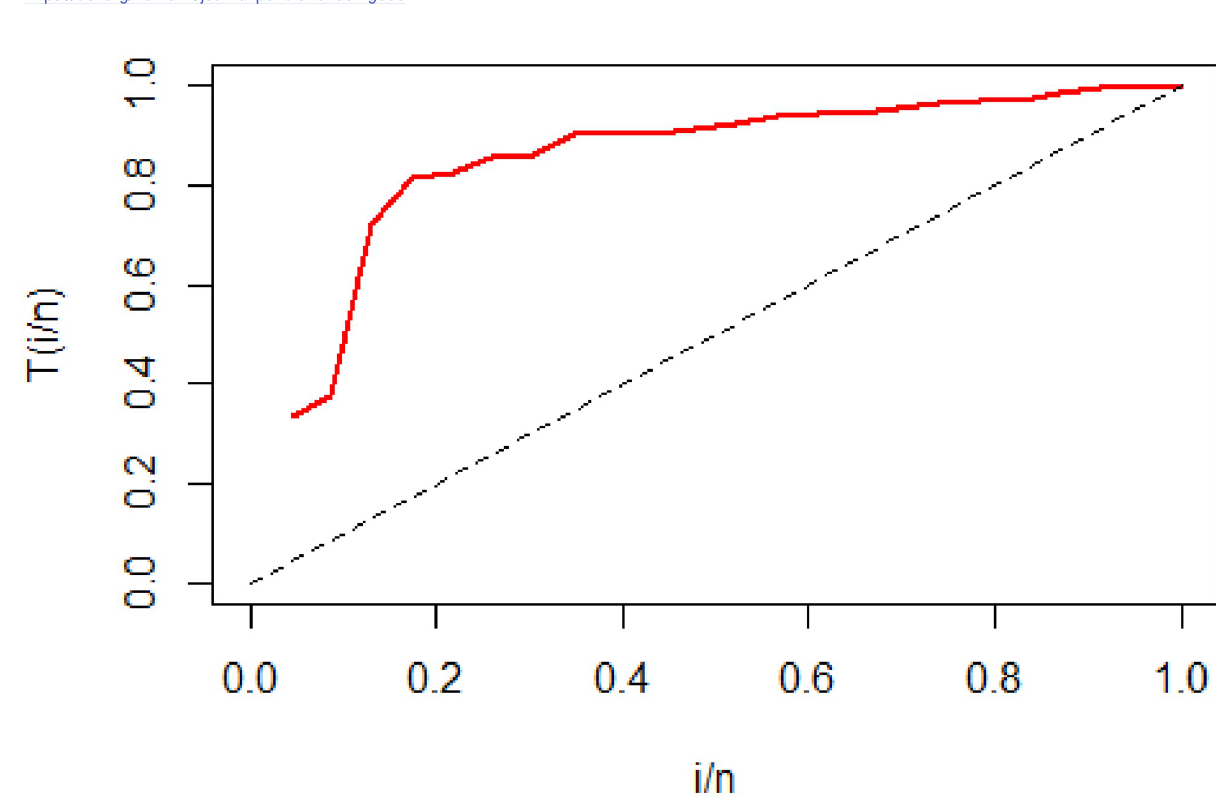
Fig 10. TTT plot for eye data